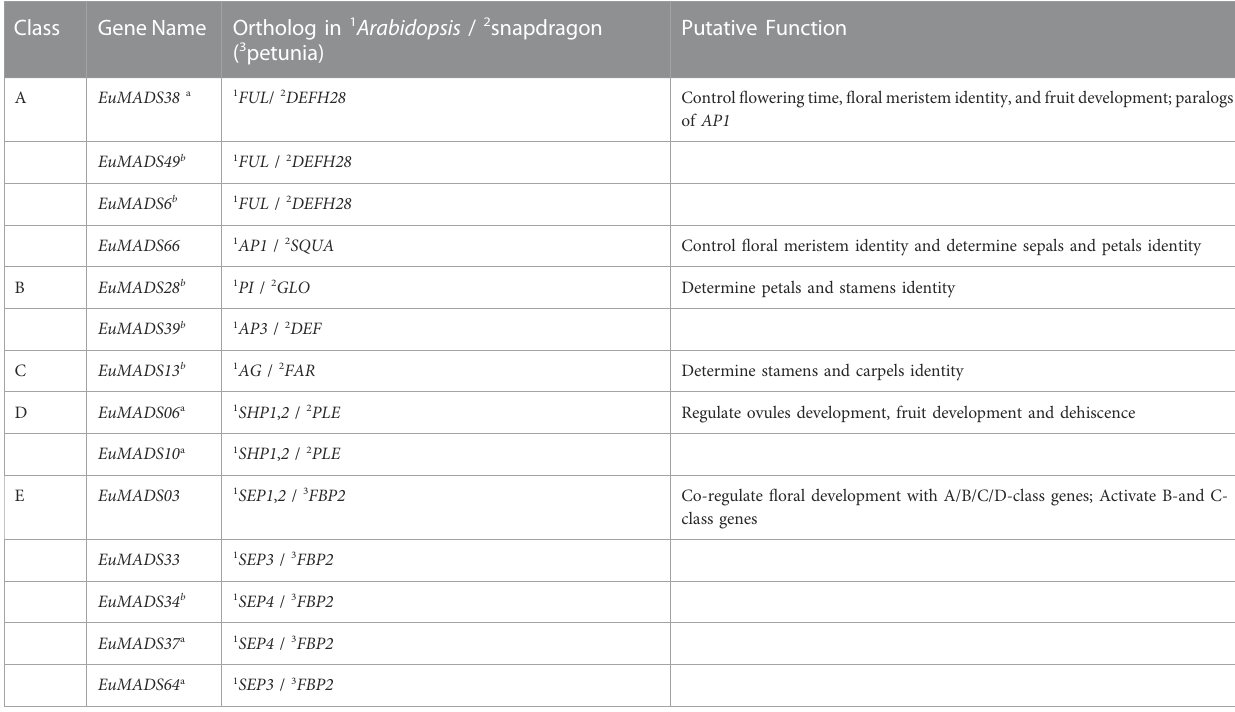
TABLE 2 Function annotation of EuMADS genes involved in ‘ ABCDE model ’ of fl ower